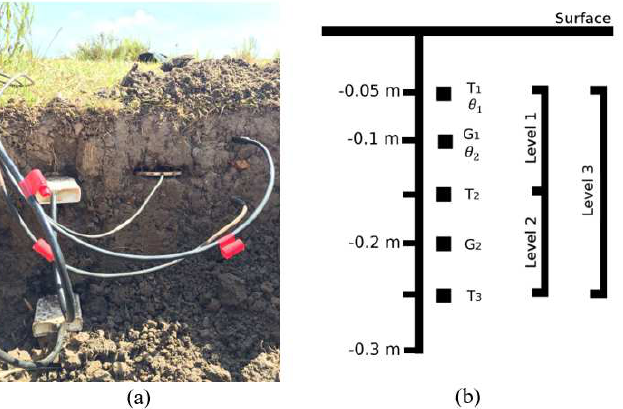
Figure 1. ( a ) Sensors installed in different layers in the ground at the experimental site of Aceguá-RS. ( b ) Position configuration of the soil sensors installed at the experimental site. G i represents soil heat flux sensors, θ i represents soil water content sensors for i = 1 . . . 2 and T i represents soil temperature sensors for i = 1 . . . 3. Table 1. Soil physical properties at the experimental site of Aceguá.